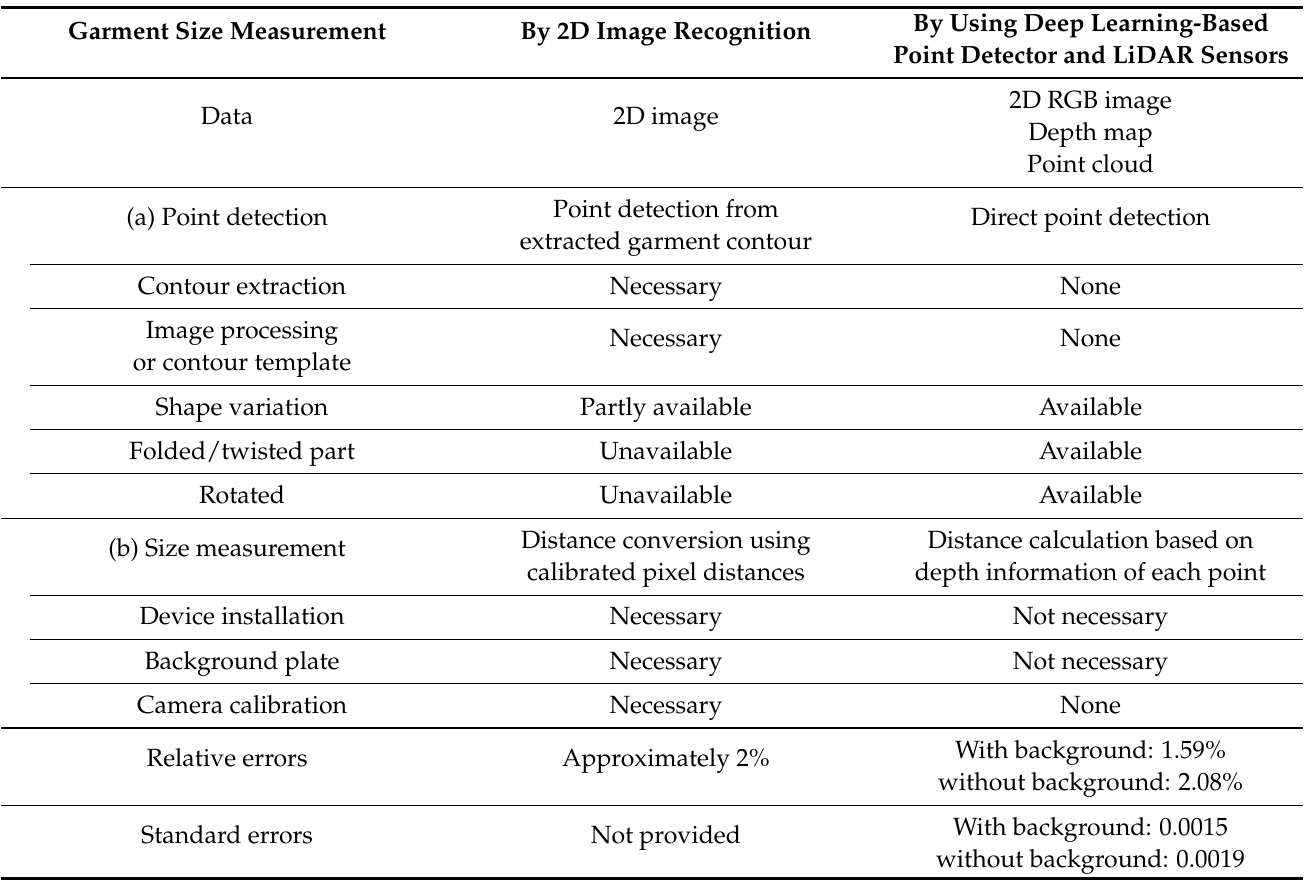
Table 3. Comparison table with previous garment sizing methods. Since the previous methods derived the actual sizes from the images, all environmental factors between the camera and the clothes had to be strictly controlled. On the other hand, our method (using the LiDAR sensor) does not require any of these